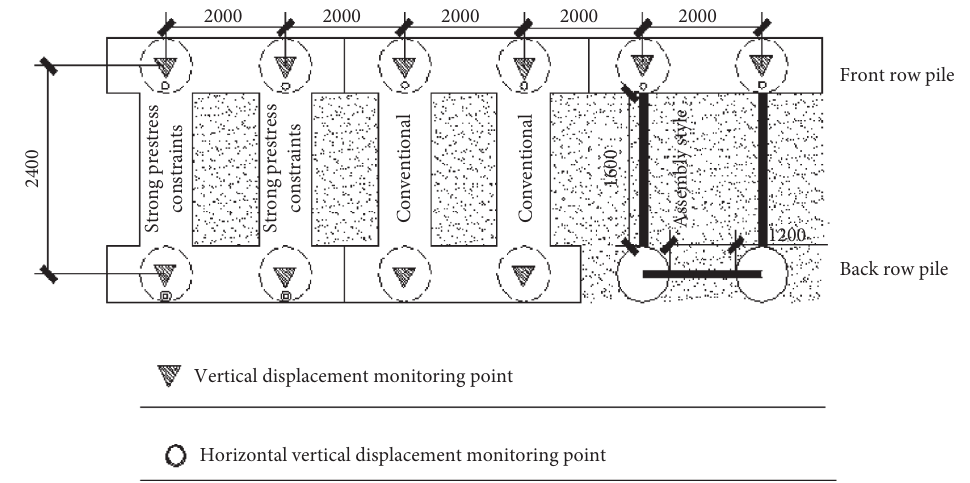
Figure 6: Pile top displacement measurement point plan